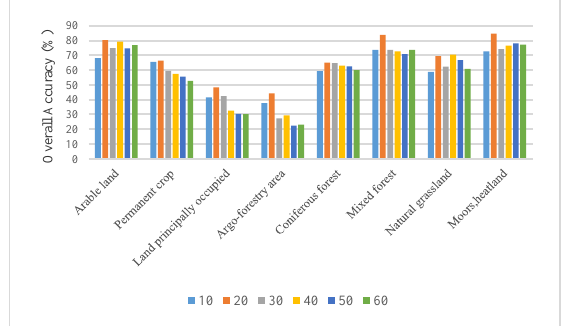
Figure 8. Average of overall accuracy obtained from the second experiment (with fine-tuning the parameters) on Sentinel-2 image for each class with ResNet 101 Figure 5. Average of overall accuracy obtained from the first experiment (without fine-tuning the parameters) on Sentinel-2 image.